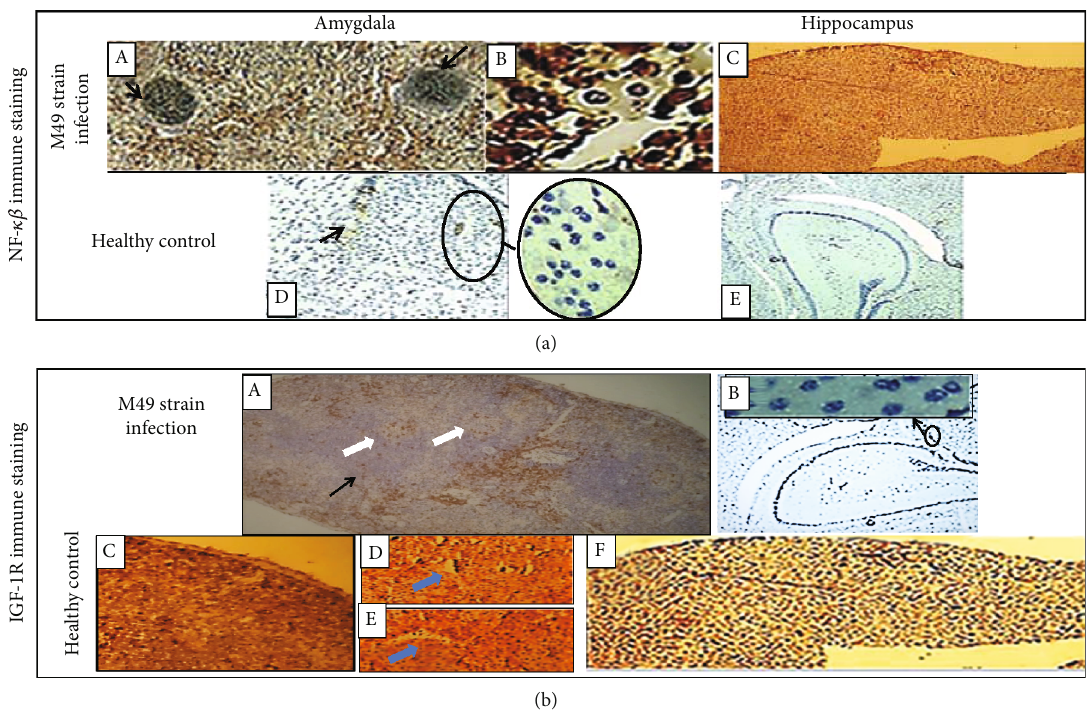
Figure 3: Double-labelled immunohistochemistry in the amygdala and hippocampus for the in situ biomarker assays. (a) Immune reactivity for NF- κβ . In the infected mice: (A) marked expression of NF- κβ in amygdala containing T. gondii cysts (black arrows) (l00x), (B) nuclear and cytoplasmic expression of NF- κβ in the perivascular mononuclear in fl ammatory in fi ltrates in the amygdala (400x), and (C) high expression of NF- κβ in the hippocampus (100x). In healthy controls: hypoexpression of NF- κβ in (D) the amygdala and (E) the hippocampus (40x). (b) Immune reactivity for IGF-1R. In the infected mice: (A) hypoexpression of IGF-1R around T. gondii cyst (black arrow) and microvasculature (white arrows) in the amygdala (40x) and (B) low evidence of IGF-1R immune staining in the hippocampus (40x). In the healthy controls: (C) high expression of IGF-1R in the amygdala (100x), (D, E) perivascular expression of IGF-1R (blue arrows) (400x), and (F) marked expression of IGF-1R in the hippocampus (100x). Spearman ’ s rho showed that NF- κβ and IGF-1R area percentage and O.D. were in moderate negative correlations, -0.584 and -0.725,